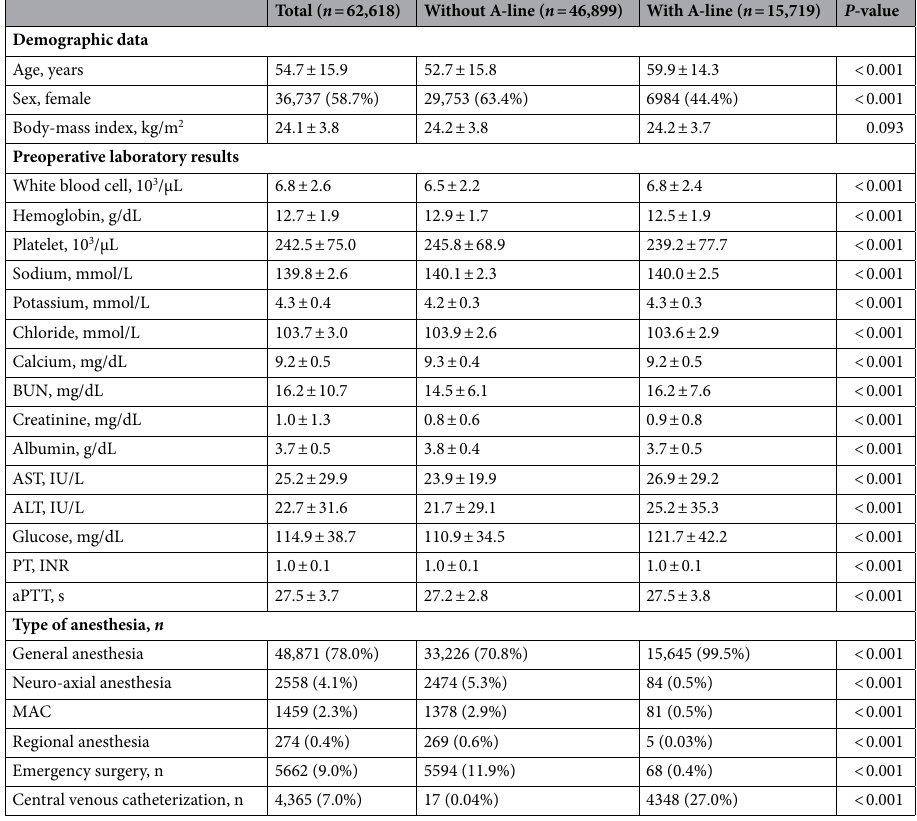
Table 1. Study group characteristics with and without arterial catheterization. Data represent mean ± standard deviation, median (interquartile range), or number (percentage). A-line, arterial line; BUN, blood urea nitrogen; AST, aspartate aminotransferase; ALT, alanine aminotransferase; PT, prothrombin time; aPTT, Activated partial thromboplastin time; MAC, monitored anesthesia